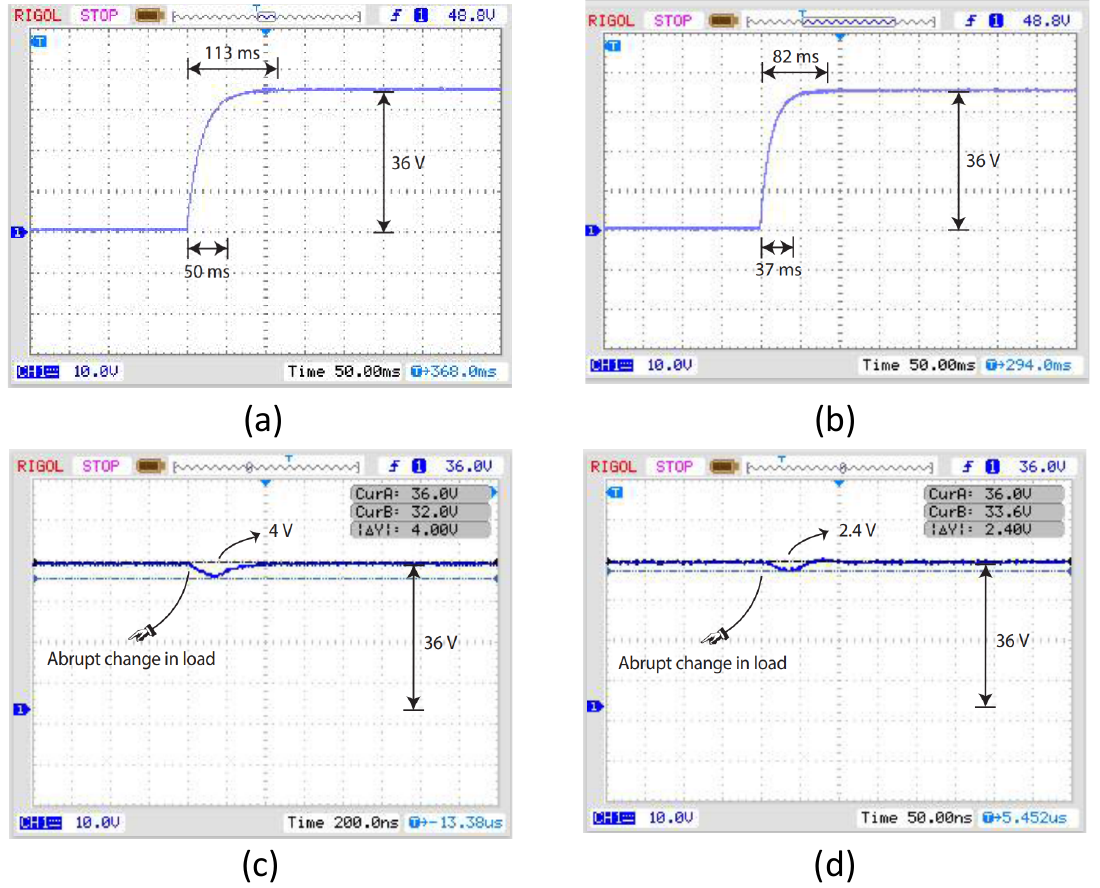
Figure 6. ( a ) Output voltages of the DC microgrid. ( b ) Gating sequence given to the power converter. ( c ) Steady state error occuring in a DC microgrid during droop operation.